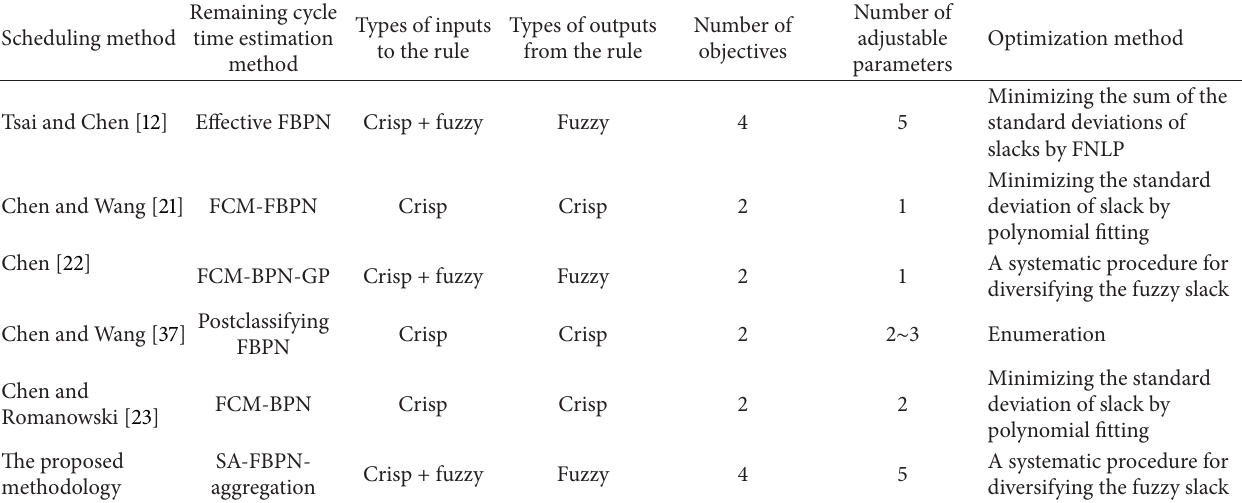
Table 2: The differences between the proposed methodology and some predictive methods.